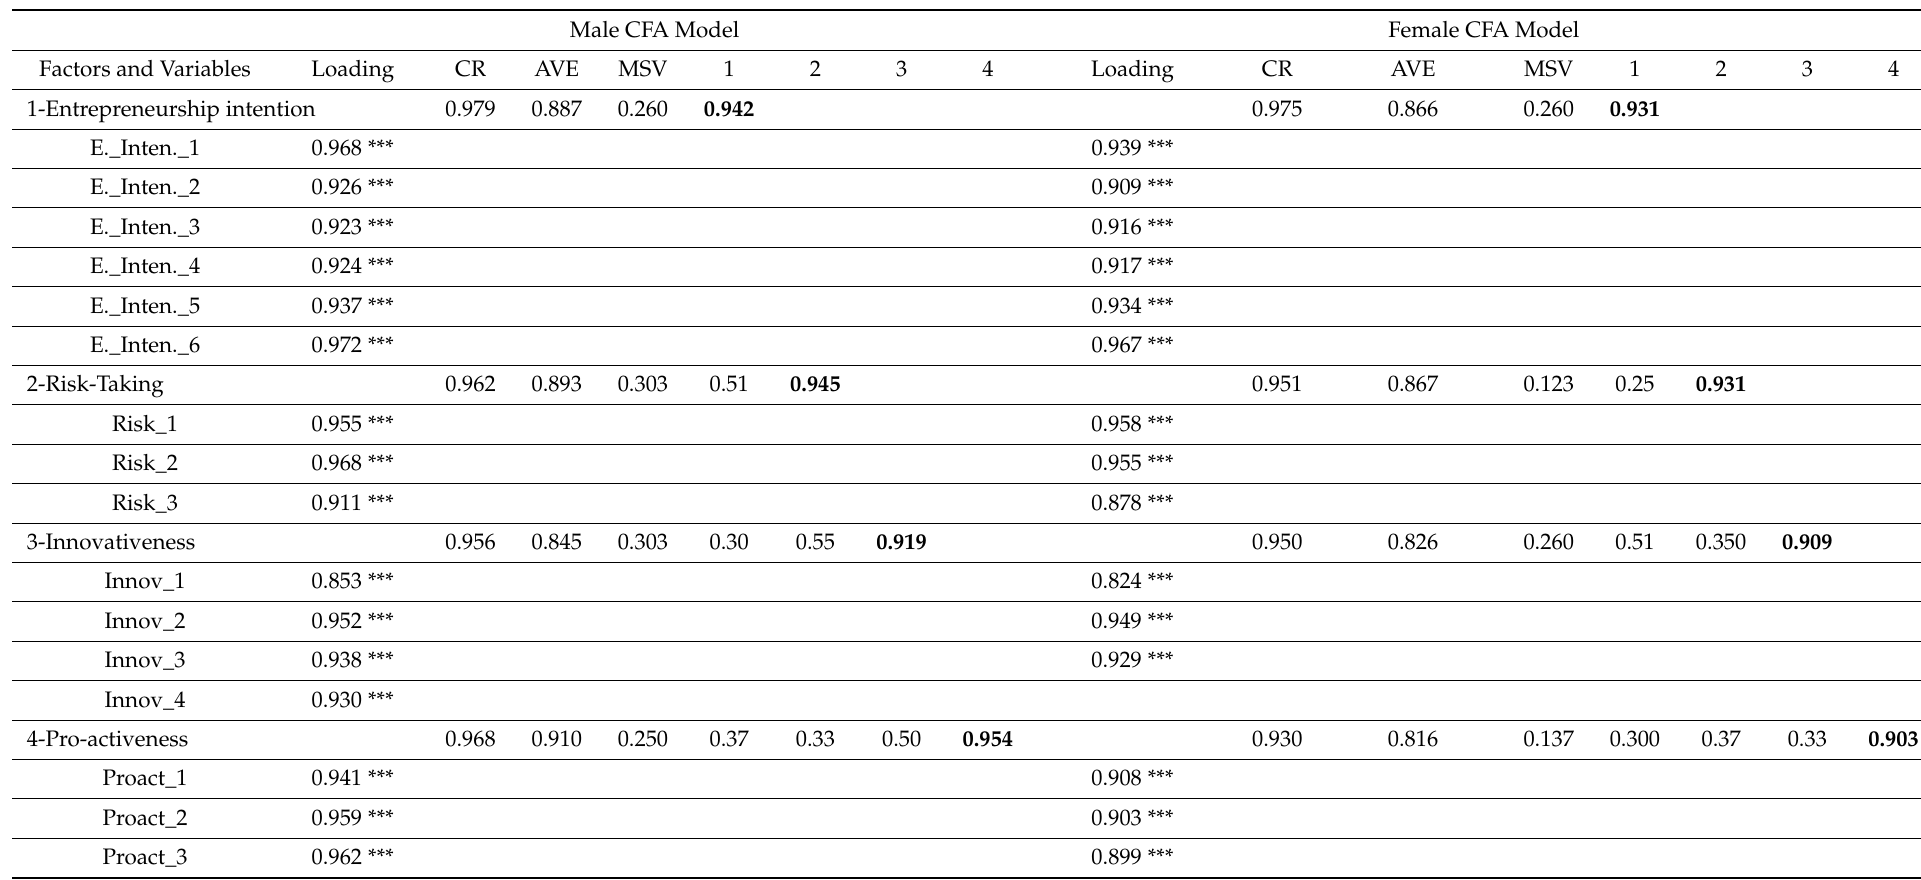
Table 2. Psychometric properties of the study